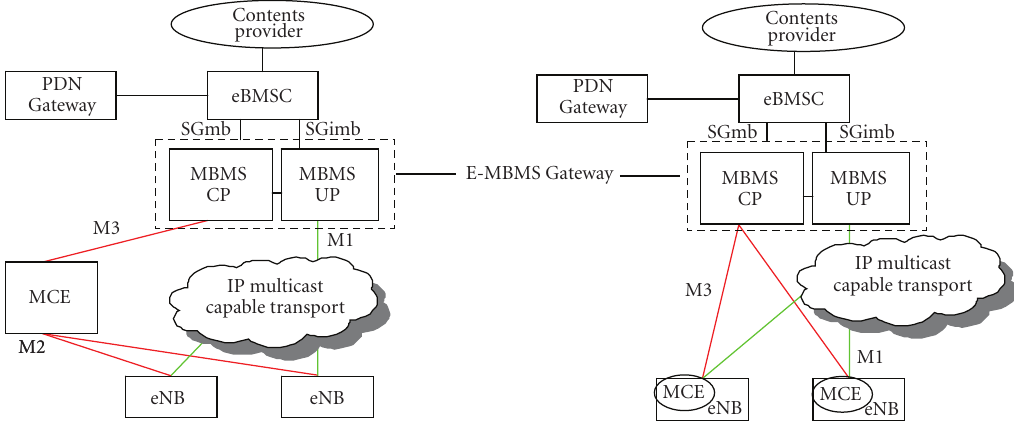
Figure 19: Overview of proposed architecture for MBMS in SAE/LTE (left) separate MCE, (right) MCE functionality integrated into